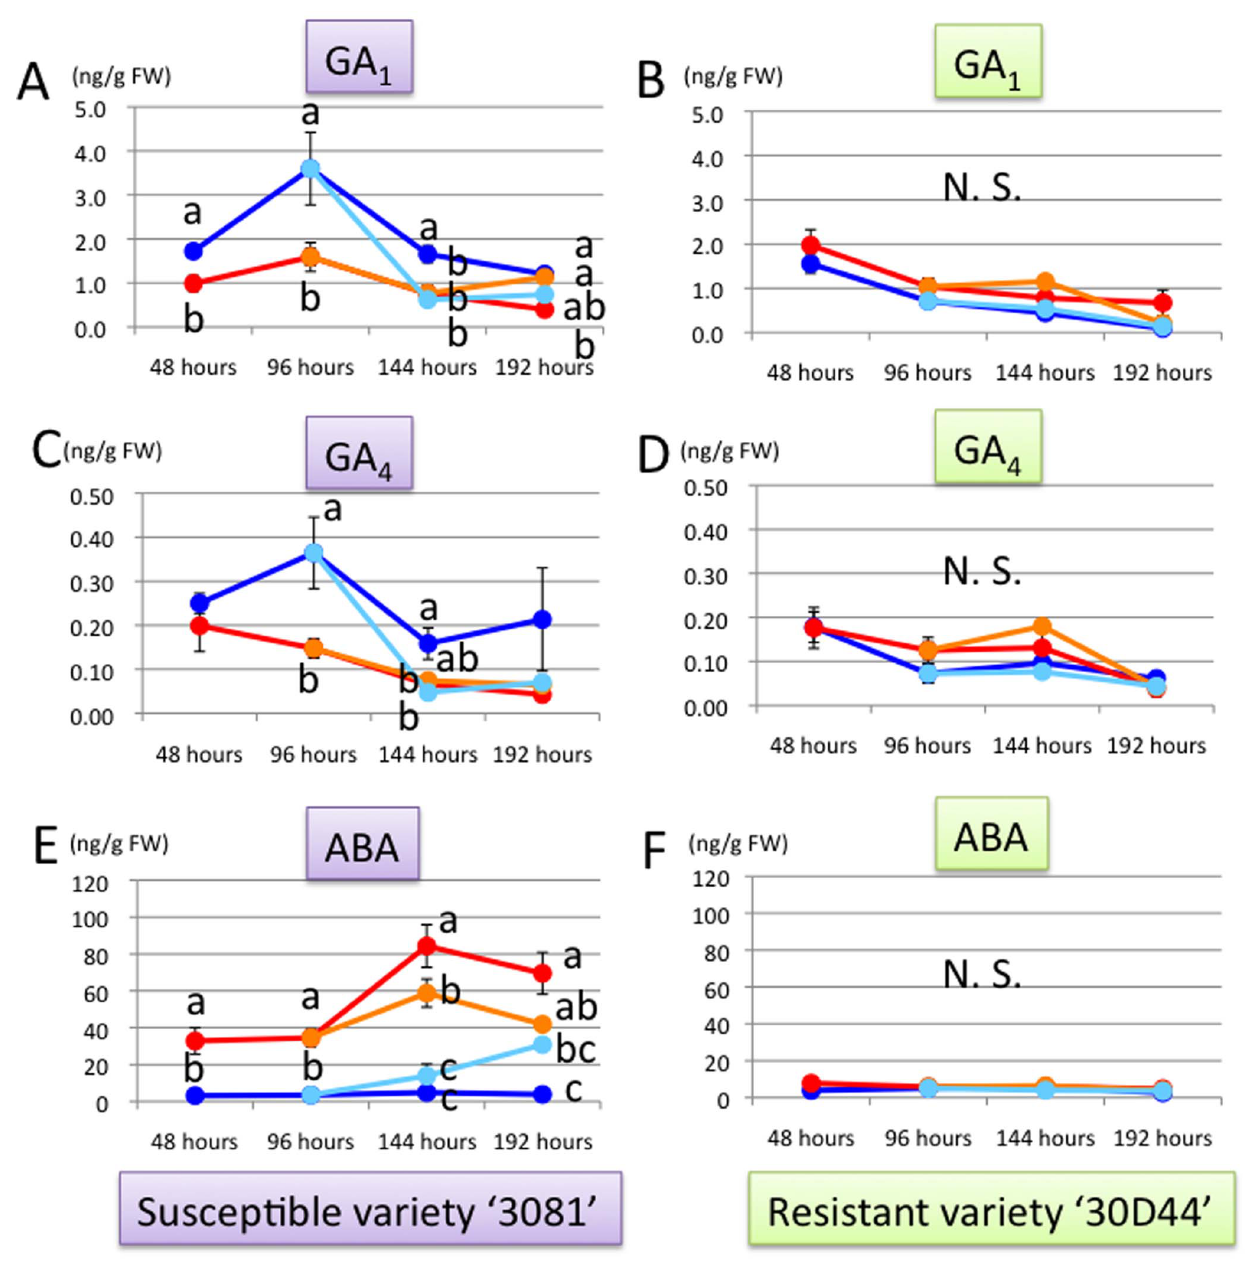
Figure 2. Changes in GA 1 , GA 4 and ABA concentrations in the third leaf of maize. (A) GA 1 concentration (ng/FW) in the variety ‘3081’. (B) GA 1 concentration (ng/FW) in the variety ‘30D44’. (C) GA 4 concentration (ng/FW) in the variety ‘3081’. (D) GA 4 concentration (ng/FW) in the variety ‘30D44’. (E) ABA concentration (ng/FW) in the variety ‘3081’. (F) ABA concentration (ng/FW) in the variety ‘30D44’. Line colors indicate leafhopper treatment for eight days (red lines), control (blue lines), early leafhopper treatment for four days (orange lines), and late leafhopper treatment for four days (light blue lines). Different letters indicate significant differences between control and treatments at each time point (ANOVA; followed by Tukey’s HSD test at 144 and 192 hours).